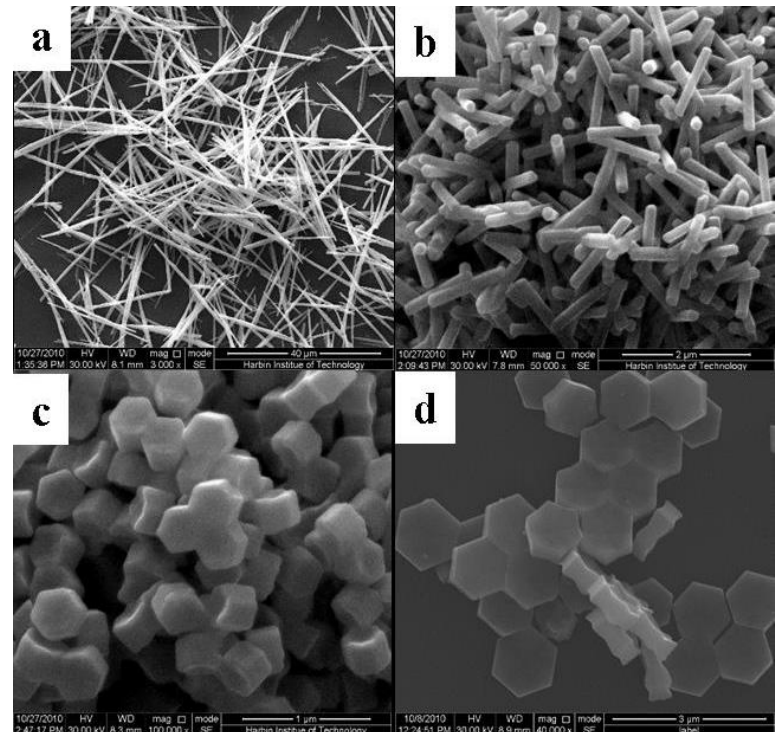
Figure 3. Typical FESEM images for the as-prepared NaYF microcrystals at different molar ratios of OA/Ln 3+ : ( a ) 6:1; ( b ) 20:1; ( c ) 30:1; and ( d ) 40:1 (Other synthetic parameters were kept identical, 180 °C, 24 h, F − /Ln 3+ =